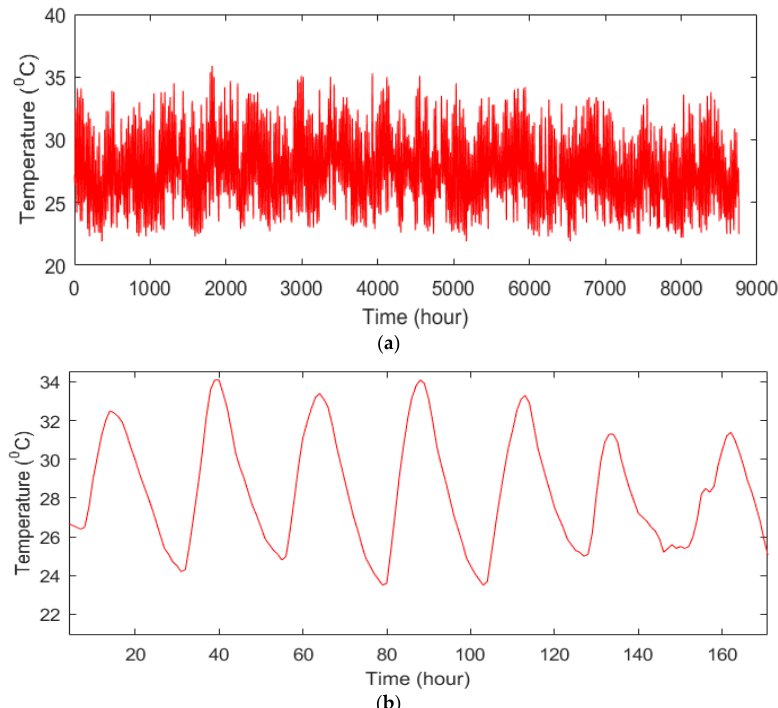
Figure 4. Temperature of Kuala Lumpur during ( a ) a year and ( b ) a week.